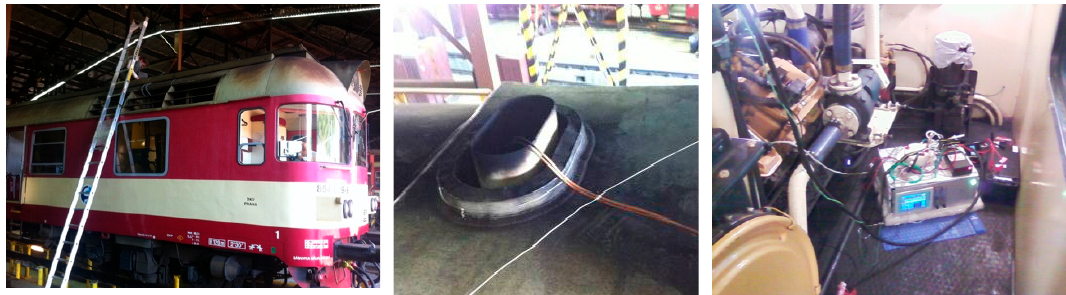
Figure 5. Series 854 diesel-hydraulic railcar tests: installation of the sampling line ( left ); sampling probe ( middle ); and portable emissions monitoring system ( right ).